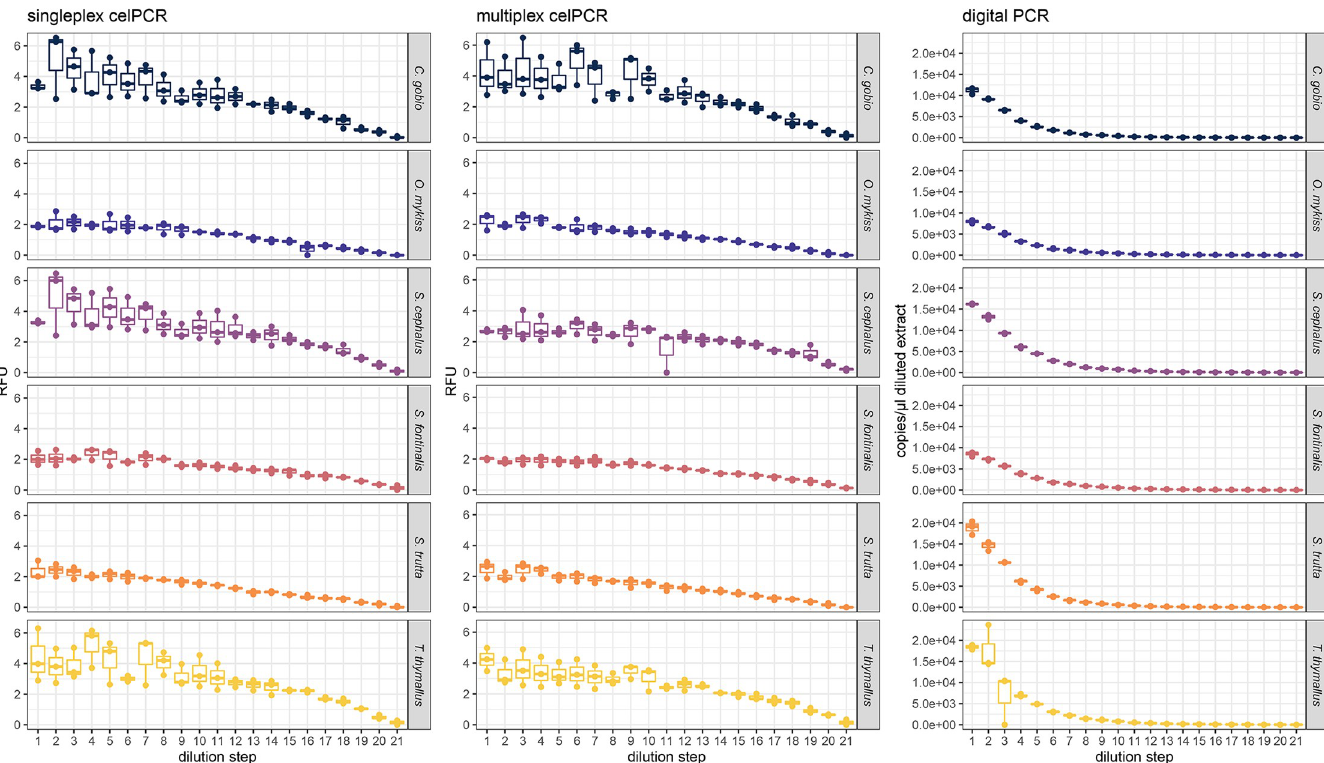
Fig 1. Singleplex and multiplex celPCR and dPCR dilution series. Relative Fluorescence Units (RFU) and template DNA copy numbers per μ l diluted extract obtained for C . gobio , O . mykiss , S . fontinalis , S . trutta , S . cephalus , and T . thymallus from singleplex celPCR, multiplex celPCR, and dPCR. Dilution steps from 5,000 copies to 1 copy per μ l extract are abbreviated 1 to